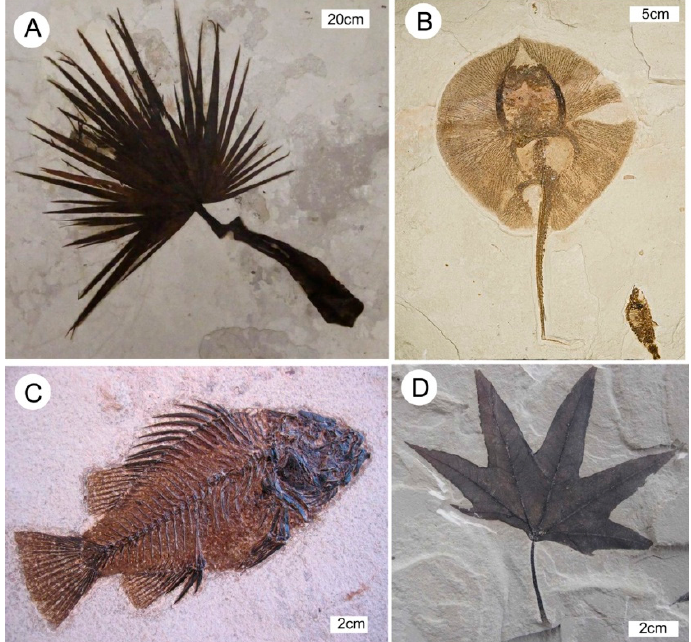
Figure 4. Green River Formation fossils. ( A ) Palm frond, Sabalites powelli . Photo courtesy of Richard Dillhoff. ( B ) Stingray, Heliobatis radians . ( C ) Fish, Priscacara serratus . ( D ) Sycamore leaf, Macginitea wyomingensis .